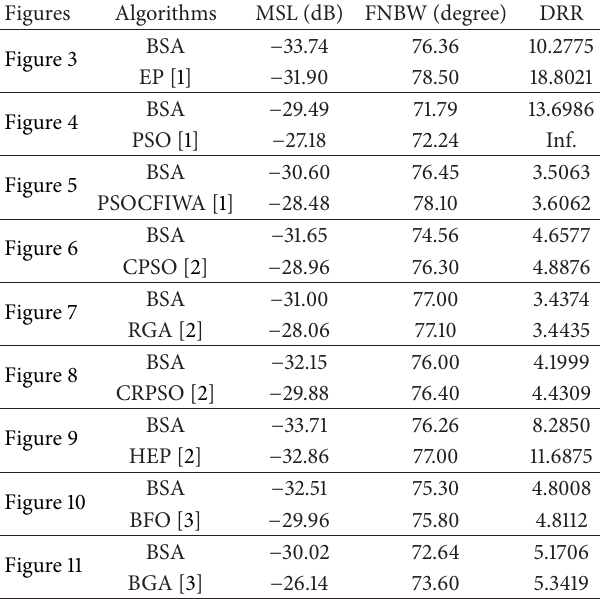
coded genetic algorithm (RGA) [2], craziness based